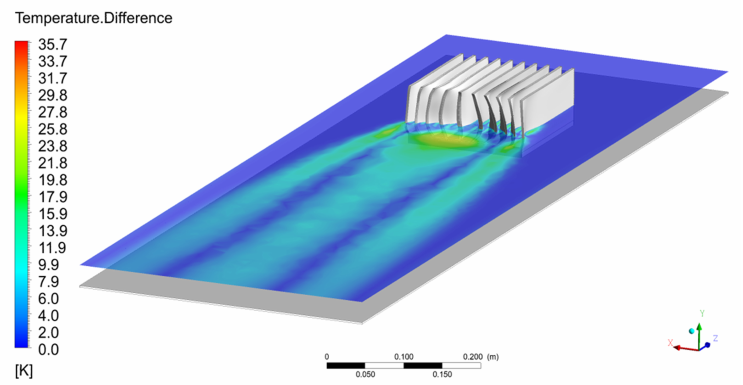
Figure 25. Differential temperature distribution between the first and last iteration.